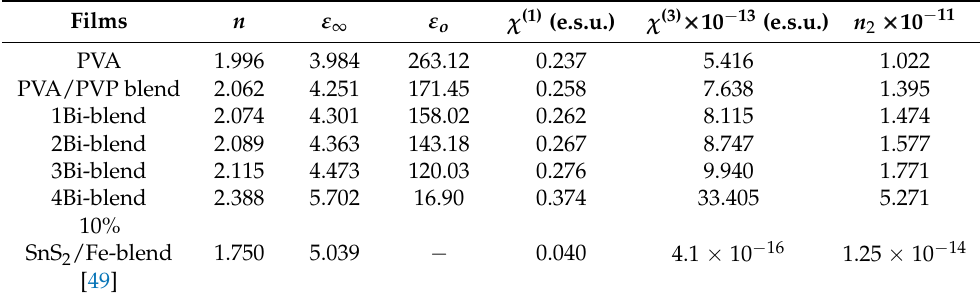
Table 2. Dielectric, L/NL optical parameters of Bi-blend hybrid films. Films